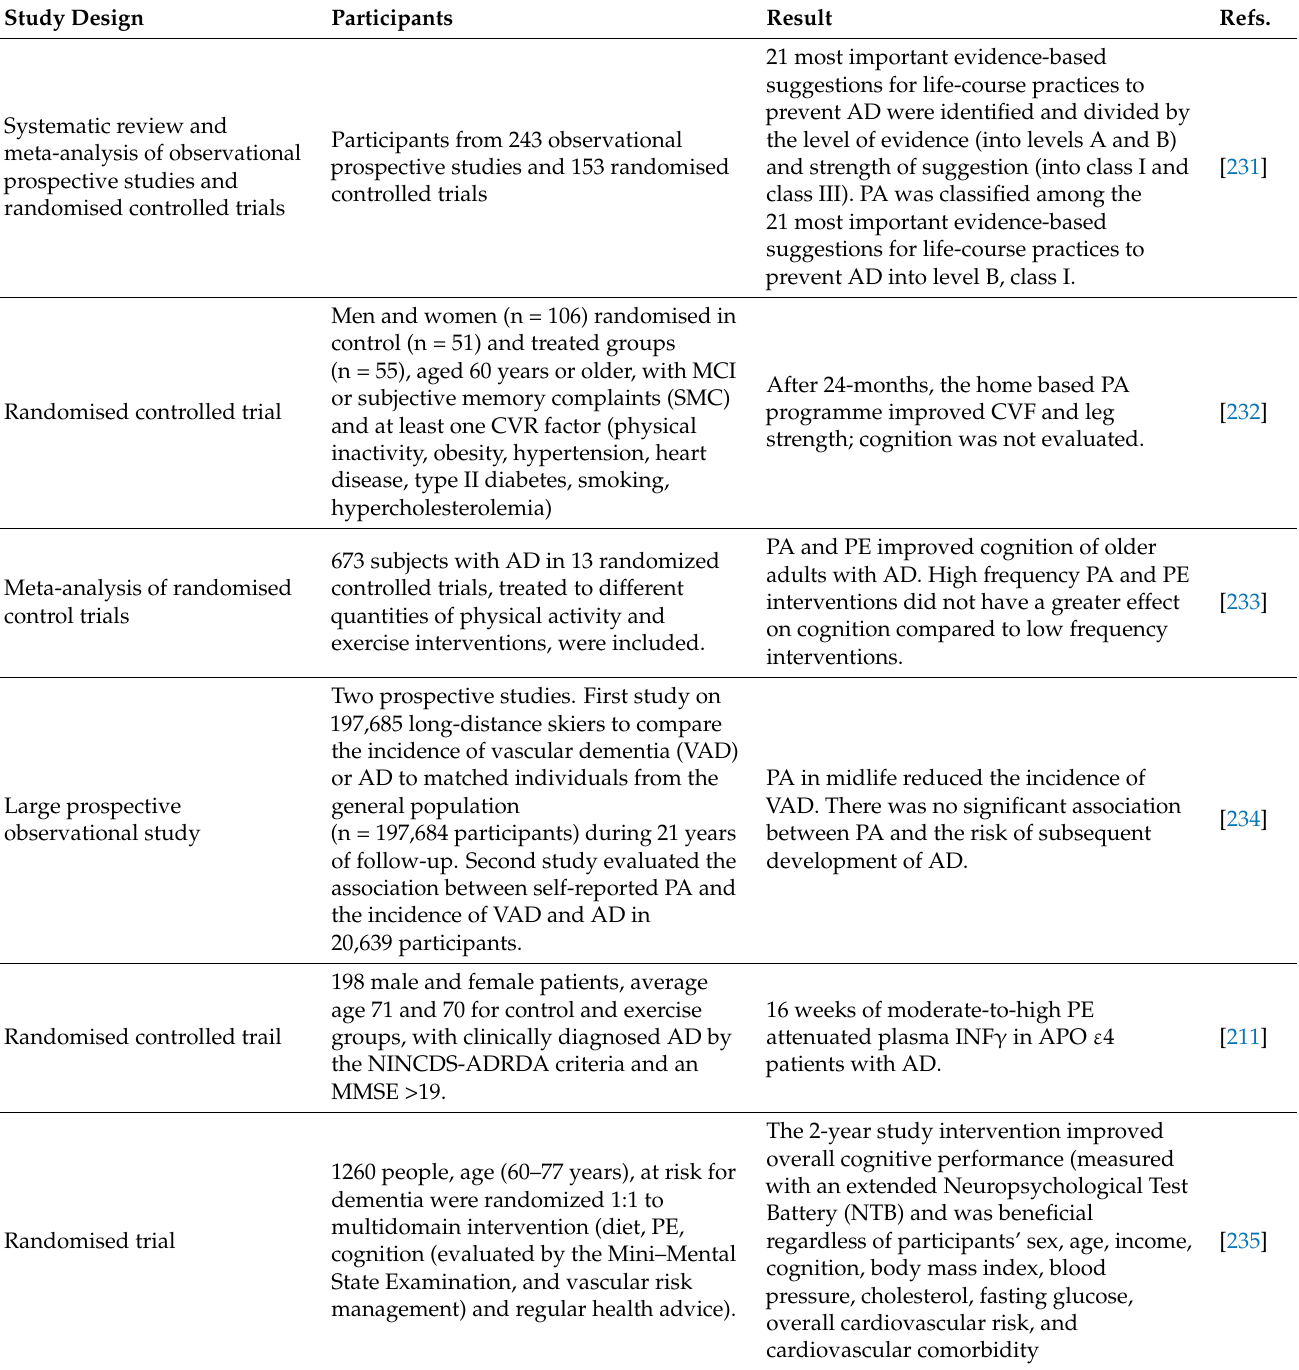
Table 1. Effect of physical activity (PA) or physical exercise (PE) on attenuating MCI, preventing the risk of AD or attenuating cognitive impairment in patients diagnosed with AD. PA refers to any movement that is carried out by the muscles that requires energy. PE is a planned, structured, and repetitive PA with the objective to improve or maintenance of physical fitness. Only two randomised controlled trails, reporting the effect of PA on inflammation in patients with AD, were published between